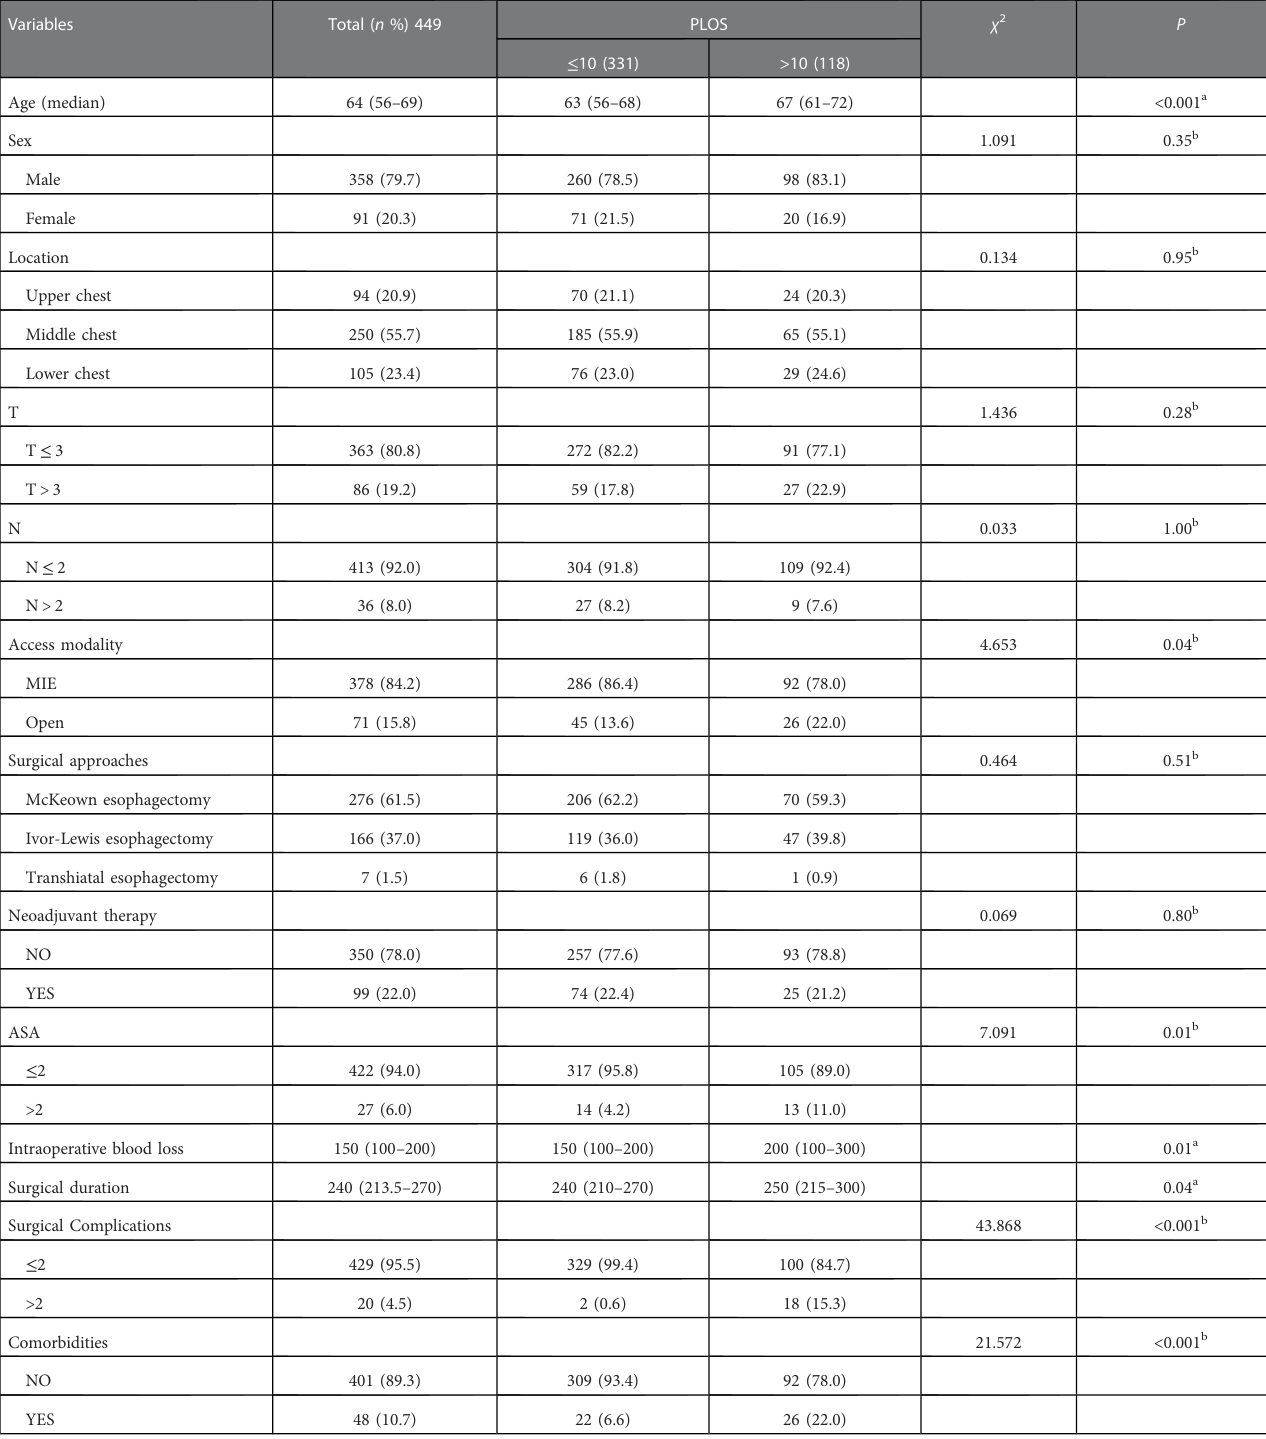
TABLE 5 Univariable analysis of delayed